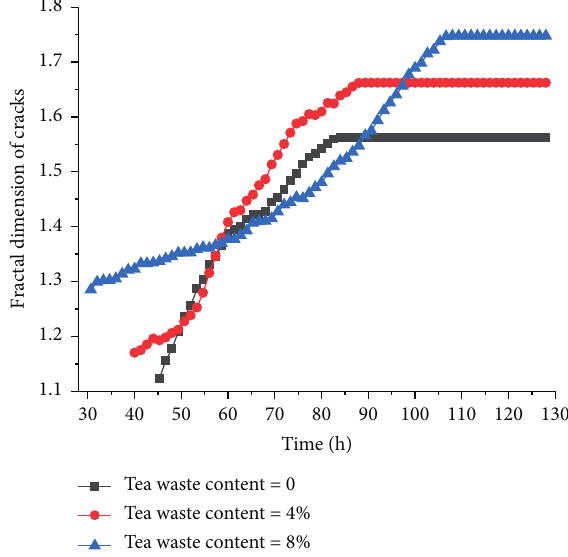
Figure 5: The fractal dimension of cracks versus different tea